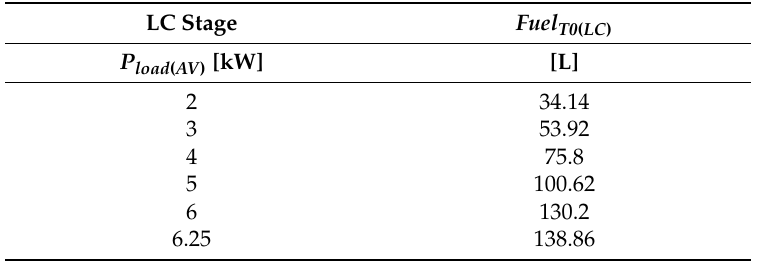
Figure 10. The behavior of the FC HPS under 6.25 kW LC (using RTO1 strategy with k fuel = 25). Table 8. The fuel economy 𝐹𝑢𝑒𝑙 𝑇𝑂(𝐿𝐶) for the sFF strategy